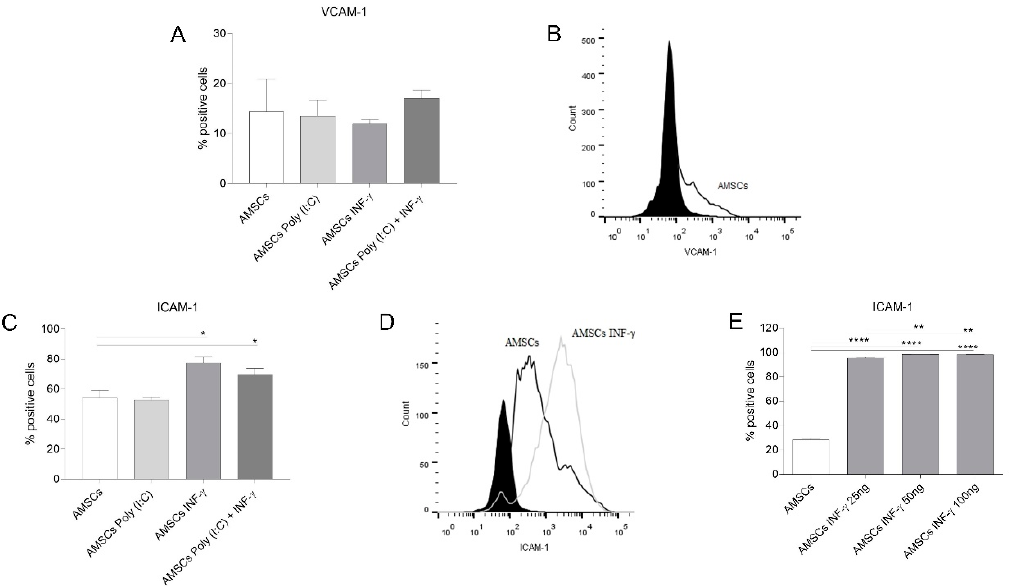
Figure 4. VCAM-1 and ICAM-1 expression of licensed and unlicensed AMSCs. ( A ) unlicensed Figure 4. VCAM ‐ 1 and ICAM ‐ 1 expression of licensed and unlicensed AMSCs. ( A ) unlicensed AMSCs, as well as AMSCs licensed with either 1 μ g/mL of Poly (I:C), 50 ng/mL of INF ‐γ or with both 50 ng/mL of INF ‐γ and 1 μ g/mL of Poly (I:C), were used to assess VCAM ‐ 1 expression by Flow Cytometry. Results are presented as mean ± SEM of three independent experiments; ( B ) Representative histogram showing VCAM ‐ 1 expression of one sample of unlicensed AMSCs;. ( C )